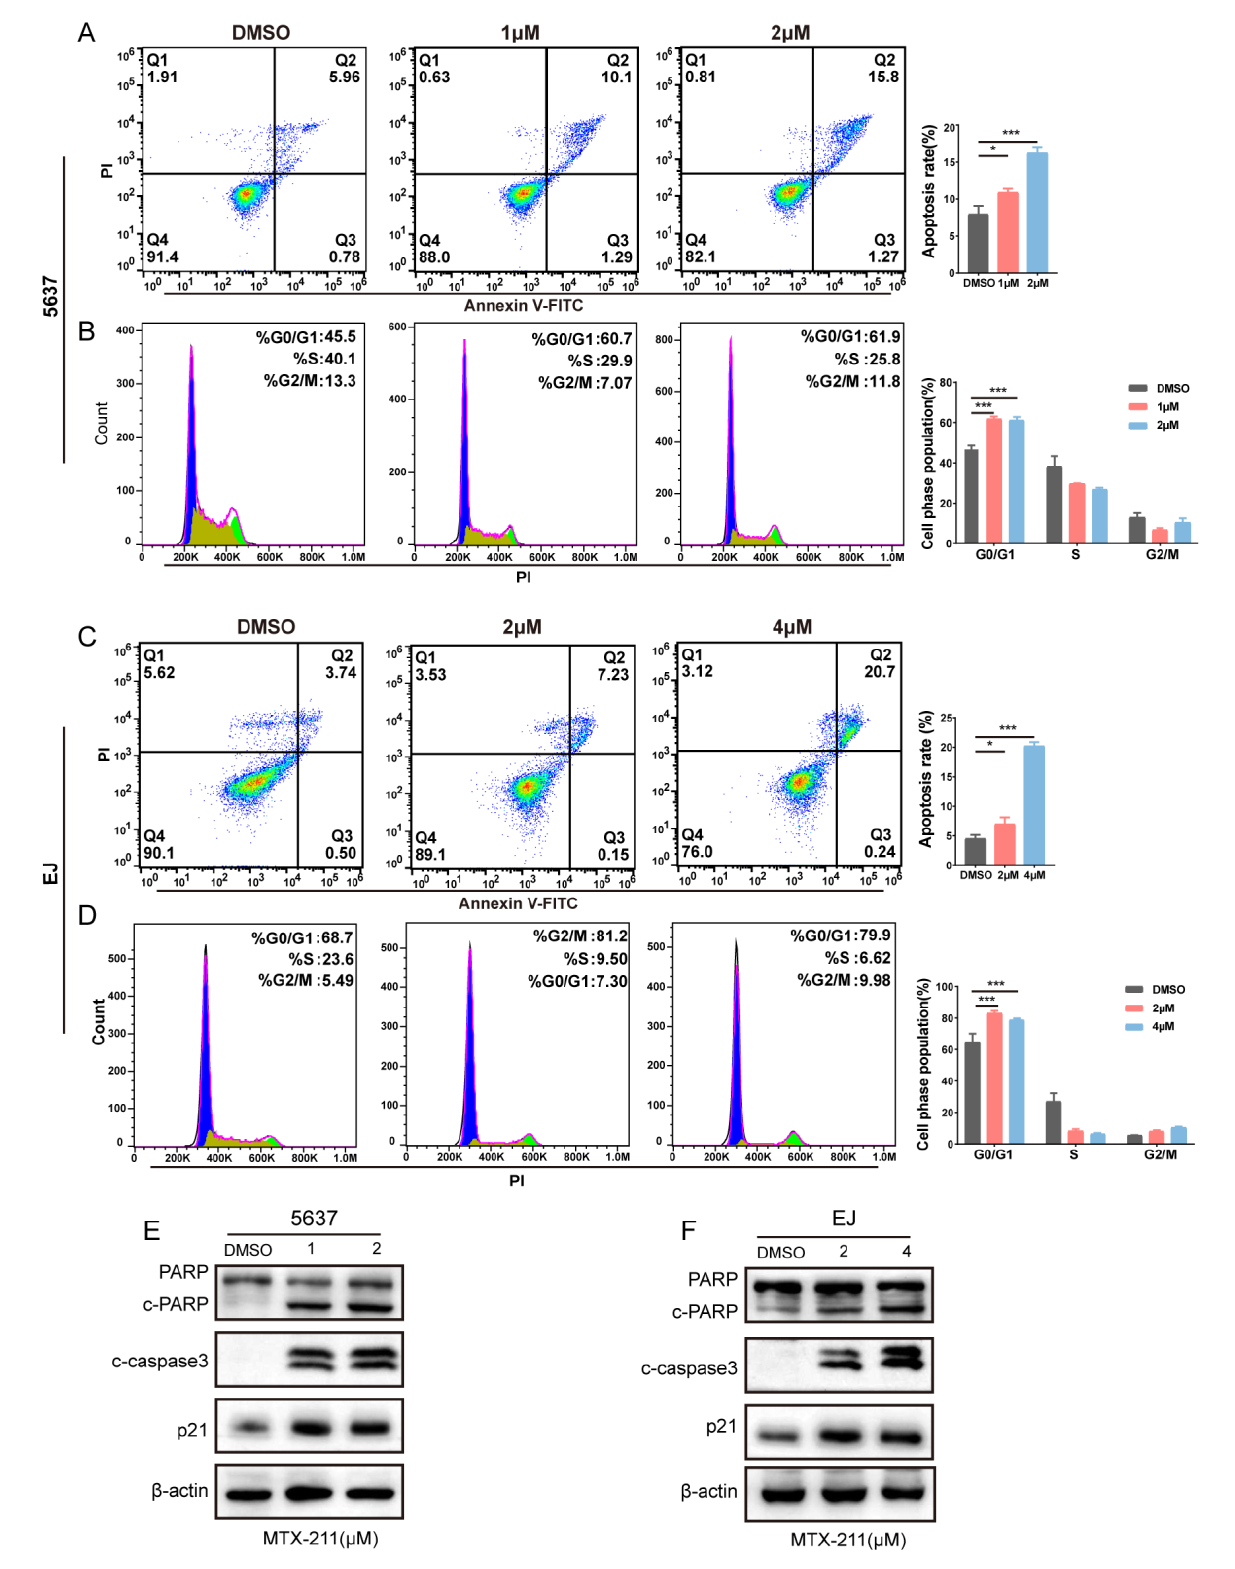
Figure 2. MTX-211 induces cell apoptosis and G0/G1 cell cycle arrest. ( A – D ) The effect of MTX-211 treatment for 48 h on the number of apoptotic cells and cells at different cell cycle phases in 5637 and EJ cells was analyzed using flow cytometry. ( E , F ) The protein expression of PARP, cleaved-caspase3, and p21 was detected using Western blotting. * p < 0.05, *** p < 0.001.